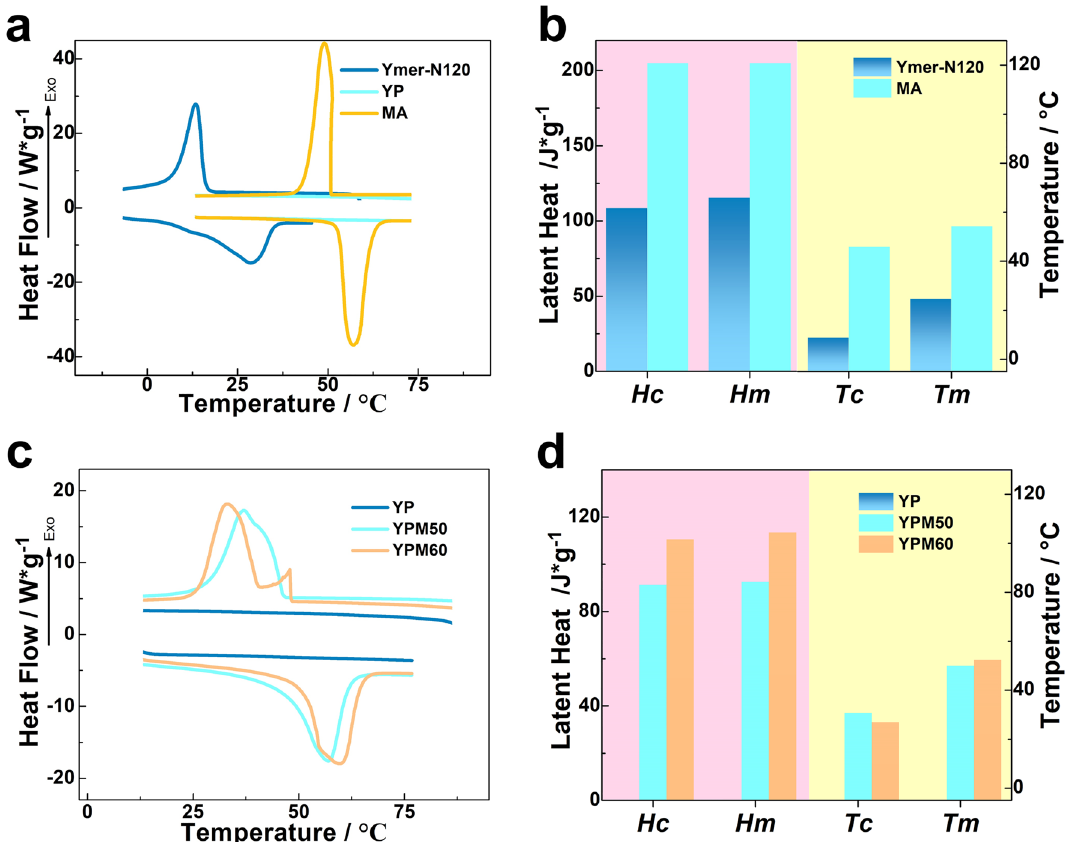
Figure 4. The ( a ) DSC curves of Ymer-N120, YP and MA ( b ) phase change properties of Ymer-N120 and MA ( c ) DSC curves of YP, YPM50 and YPM60 ( d ) phase change properties of YP, YPM50 and